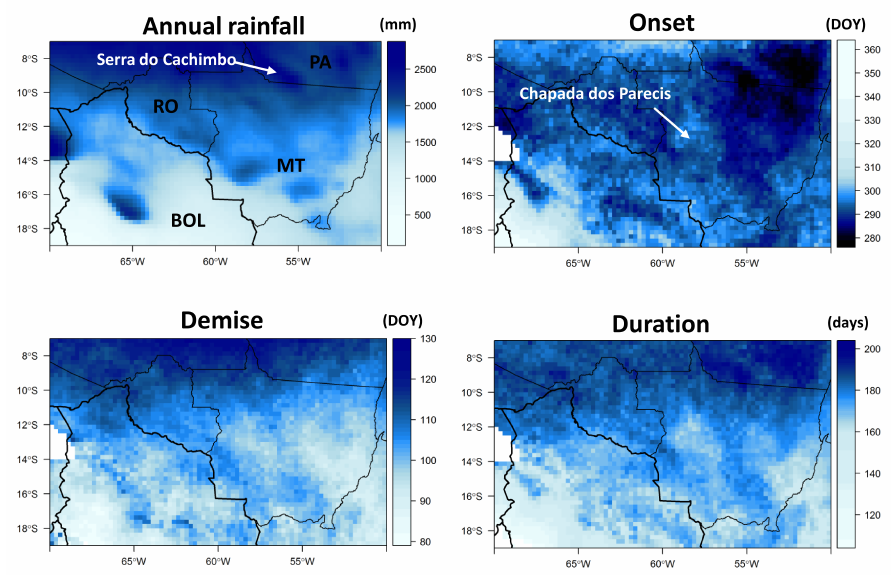
Figure 6. Mean annual rainfall, onset date, demise date and duration of the rainy season in the southern Amazon estimated from PERSIANN-CDR for the 1983–2013 time period. The onset and demise dates are defined as the number of days after 1 January. Areas in white correspond to pixels where the rainy season is not well defined according to the Köppen classification rules. (PA = Pará, MT = Mato Grosso, RO = Rondônia, BOL = Bolivia).